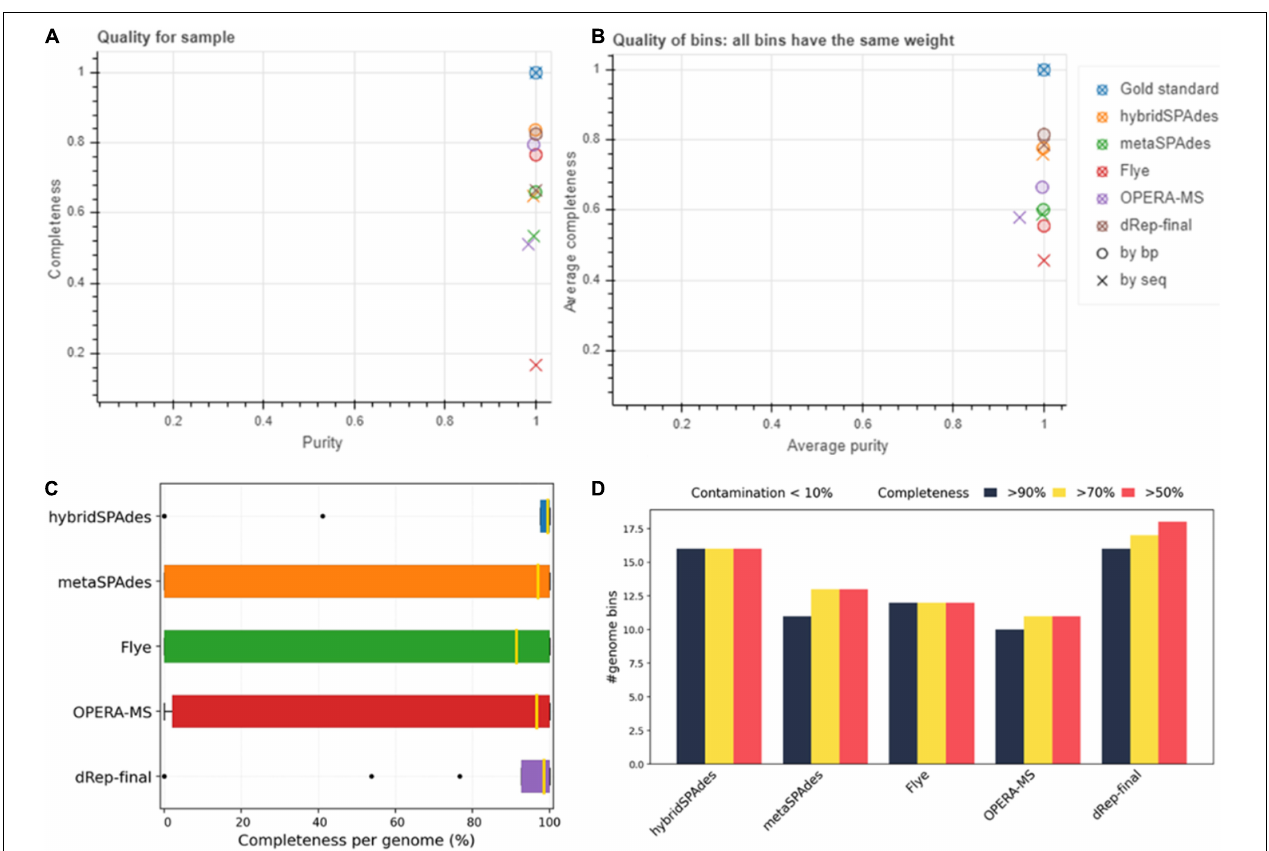
FIGURE 10 | Assessment of genome bins reconstructed from mock community (BMS21) dataset by different methods. (A) Purity ( x -axis) and completeness ( y -axis). (B) Average purity per base pair ( x -axis) and average completeness per base pair ( y -axis). (C) Box plots of purity per bin and completeness per genome, respectively. (D) Number of genomes with less than 10 and 5% contamination and more than 50, 70, and 90%